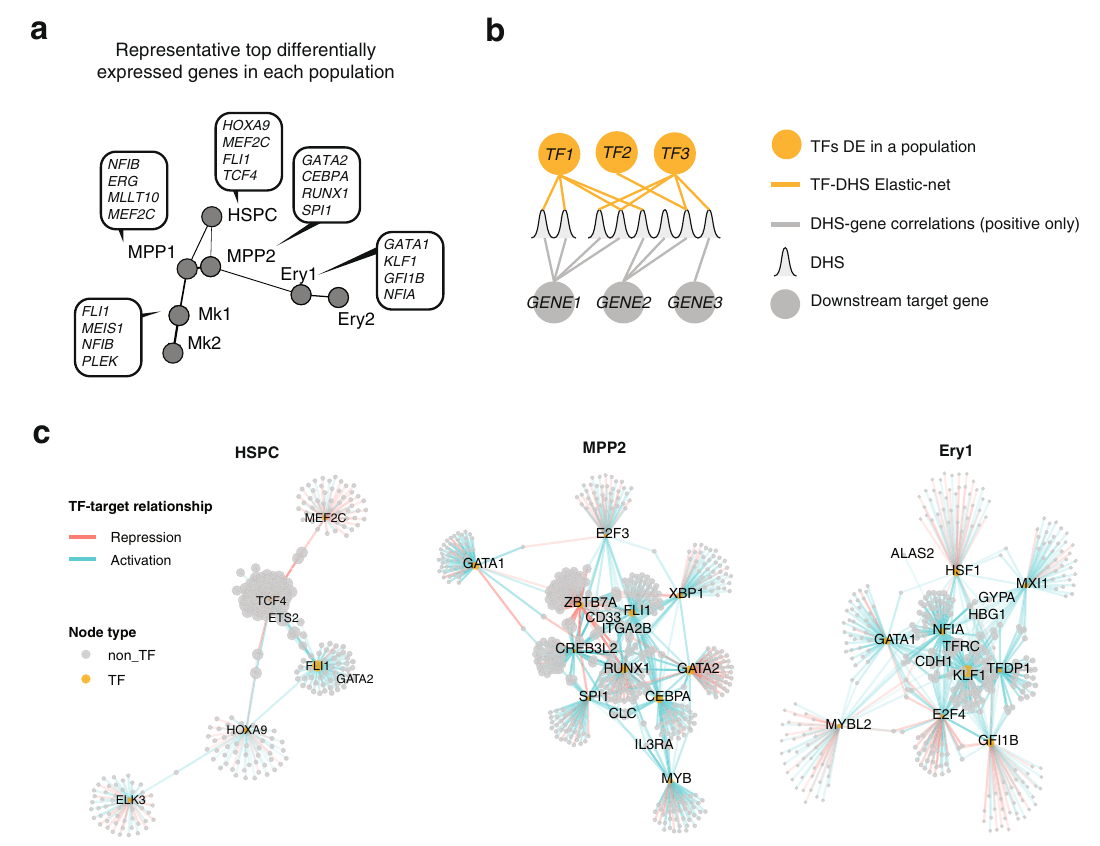
Fig. 7 De fi ning the stage-speci fi c erythroid regulatory networks. a Representative top differentially expressed TF genes between populations as identi fi ed by Wilcoxon sum rank test. b Schematic diagram of the regulatory network construction logic. Differentially expressed TFs among single-cell populations are assigned to their target genes based on elastic-net regression results. DHSs are linked to their target genes using correlation between population level DHS density and gene expression. c Regulatory networks initiated by TFs speci fi c to each population. Up to top 50 target genes are shown for each TF. Transcription factors and select marker genes are